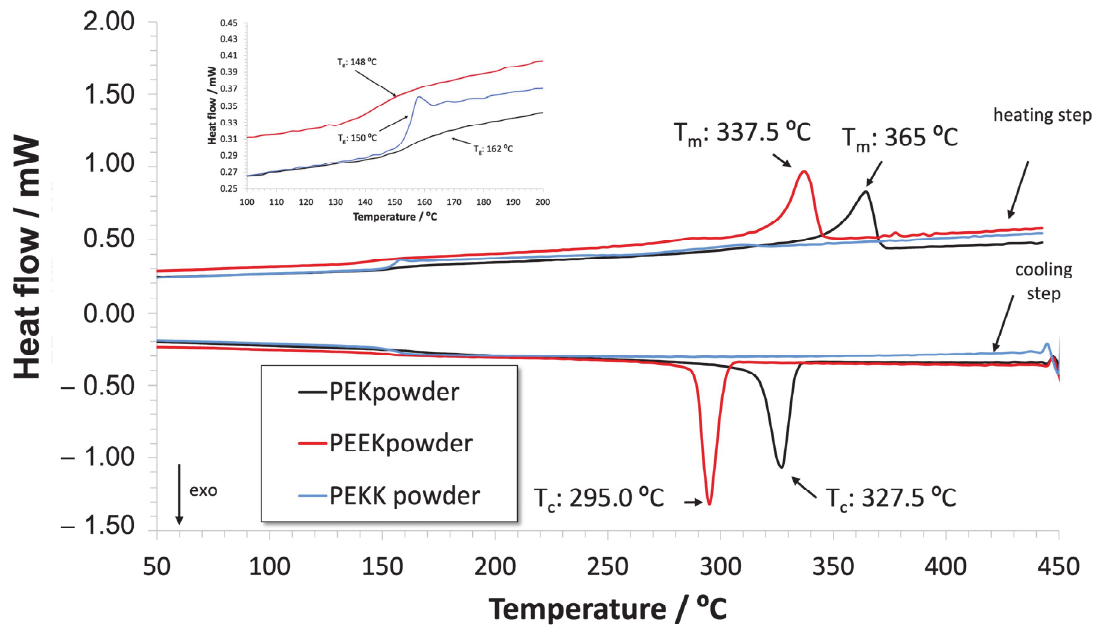
Figure 8. DSC thermograms for PEK, PEEK and PEKK powders. The insert shows a magnification of the thermograms for the glass transition temperature